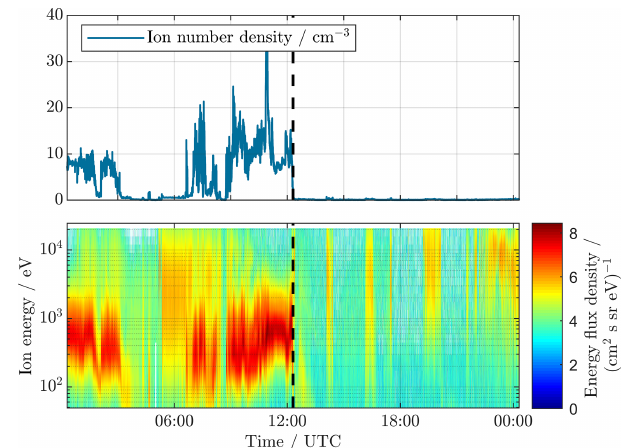
Figure 1. Example for MP crossing of THB on 24 April 2013. The probe comes from the magnetosheath and enters the magnetosphere at around 12:18UTC.